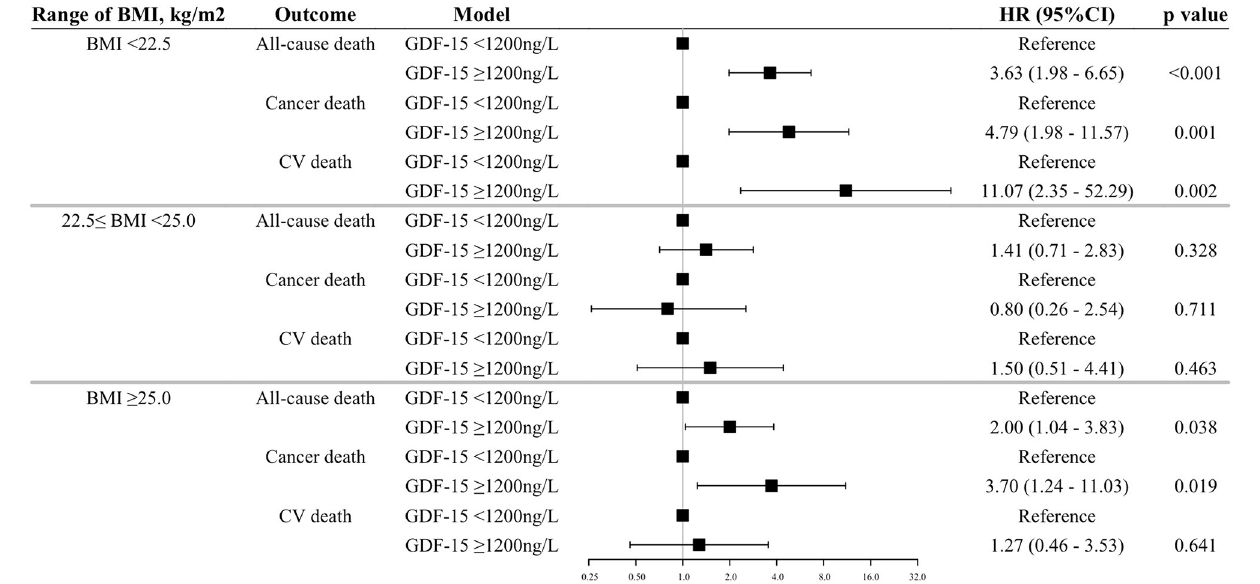
who died from malignancy might have had undiagnosed cancer at